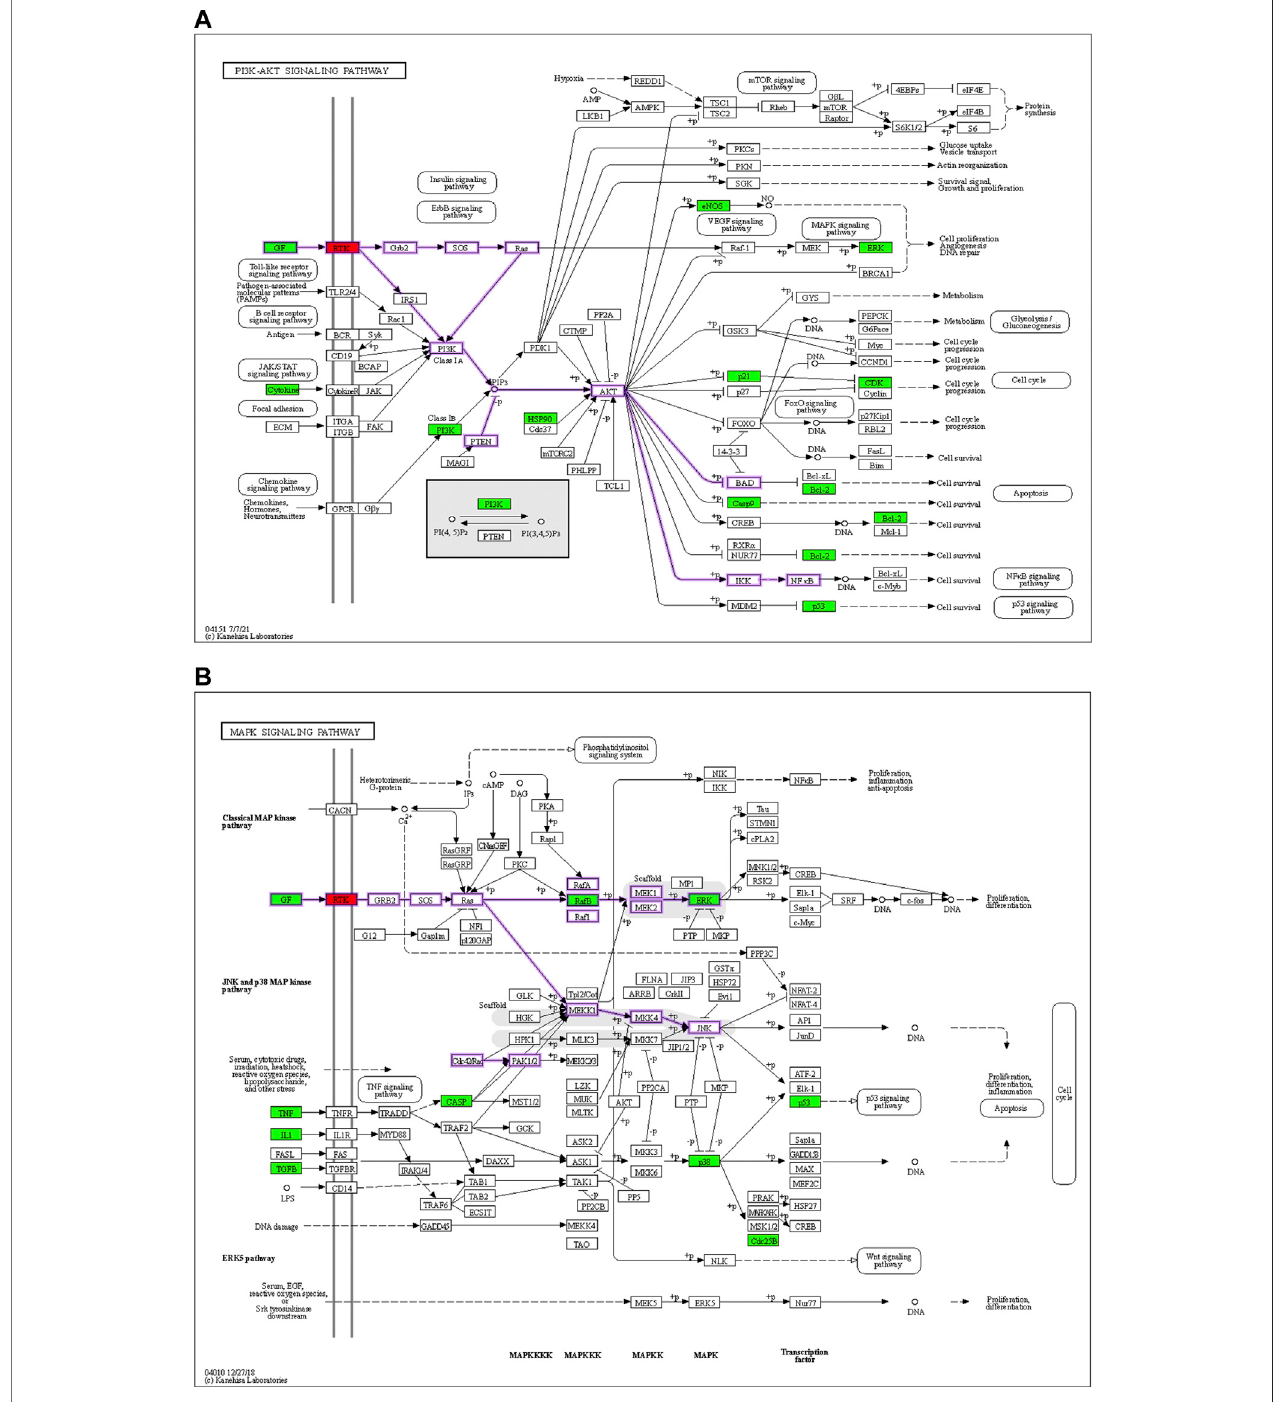
FIGURE 6 | Diagrams of the PI3K-AKT signaling pathways (A) and MAPK signaling pathways (B) . Red means the docking target to be validated, and green represents the predicted drug action target of the net drug. The membrane RTK is a collective class of targets, including EGFR, INSR, and IGF1R.